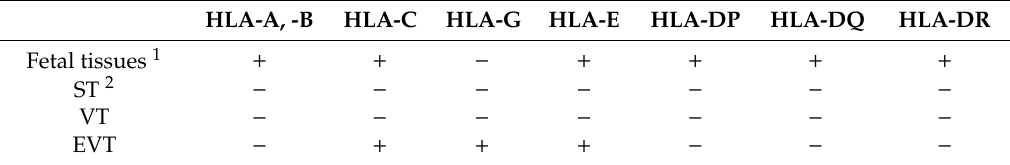
Table 1. Expression of HLA class I and II molecules at feto-maternal ST: syncytiotrophoblast; VT: villous trophoblast; EVT: extravillous trophoblast.